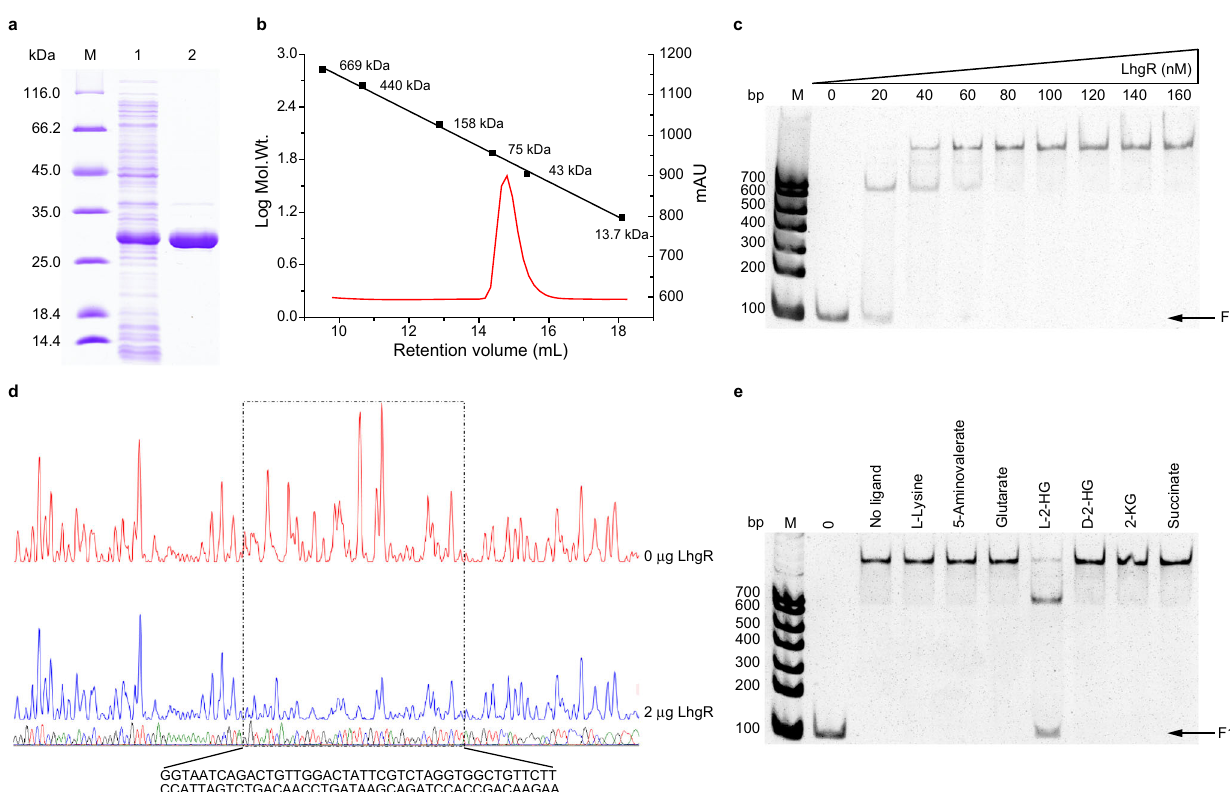
Fig. 2 Puri fi cation and characterization of LhgR. a SDS-PAGE analysis of the puri fi cation of LhgR. Lane M, molecular weight markers; lane 1, crude extract of E. coli BL21(DE3) harboring pETDuet- lhgR ; lane 2, puri fi ed His 6 -tagged LhgR using a HisTrap column. b Gel- fi ltration chromatography of the puri fi ed LhgR with the Superdex 200 10/300 GL column. Red curve, the chromatogram of puri fi ed LhgR; Black line, a standard curve for protein molecular mass standards. c LhgR can bind to the lhgO promoter region. F1 fragment containing the lhgO promoter region (10 nM) was titrated by puri fi ed LhgR (0, 20, 40, 60, 80, 100, 120, 140, 160 nM). Lane M, molecular weight markers. d DNase I footprinting analysis of LhgR binding to the lhgO promoter region. The F1 fragment was labeled with 6-carboxy fl uorescein (FAM) and incubated with 2 μ g LhgR (blue line) or without LhgR (red line). The region protected by LhgR is indicated with a dotted box. e L -2-HG prevents LhgR binding to the lhgO promoter region. EMSAs were carried out with F1 fragment (10 nM) and puri fi ed LhgR (60 nM) in the absence of any other tested compounds (No ligand) and in the presence of 50 mM different compounds. Lane M was the molecular weight marker; lane 0 without LhgR was used as the